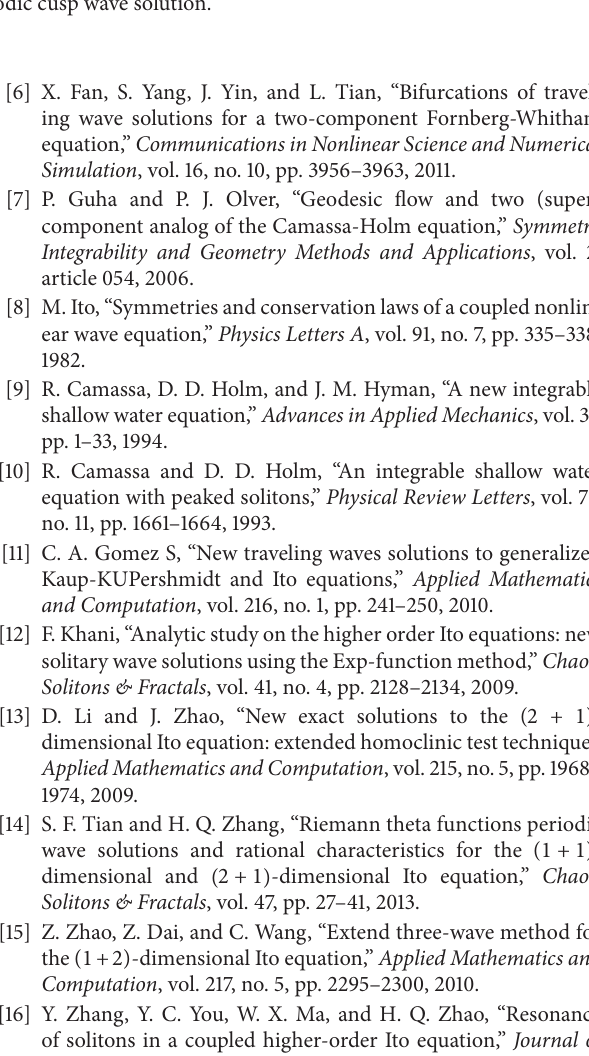
Figure 7: Valley-shape periodic cusp wave